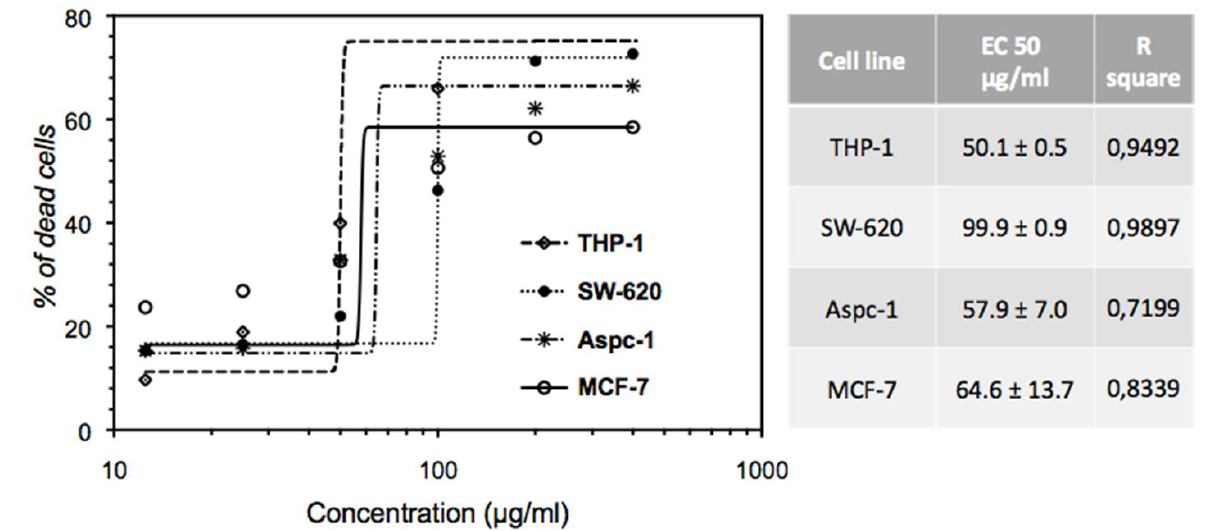
Figure 3. Dose-dependent effects of EHA-Aq fraction on cell viability in different phenotypes of human cancerous cell lines. The cells were treated with various concentrations for 24 h, and then cell death induction was analyzed by flow cytometry. EC 50 values were calculated using GraphPad Prism 6 software.